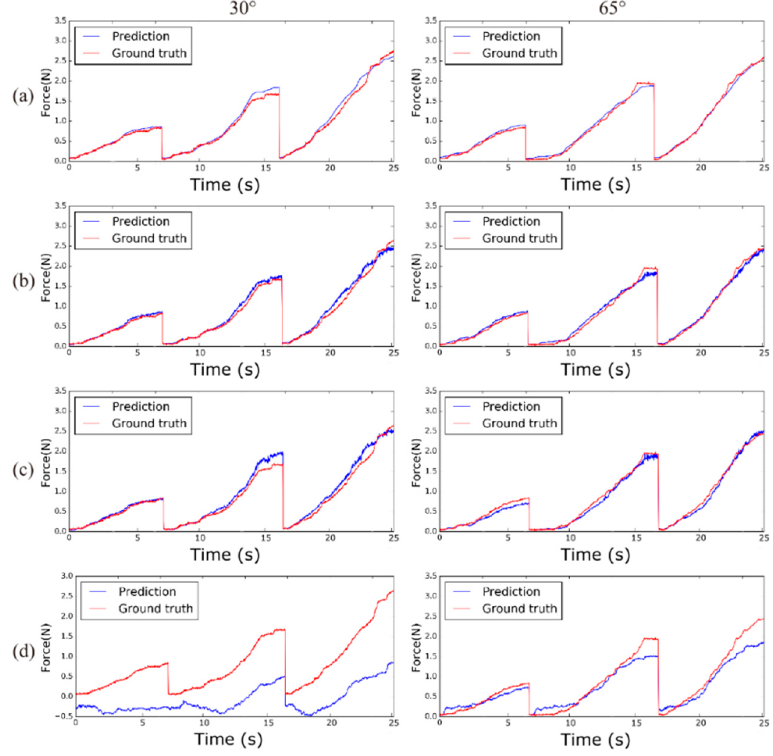
Figure 8. Tensile force estimation results from various networks. The estimation result for a 30 ◦ view